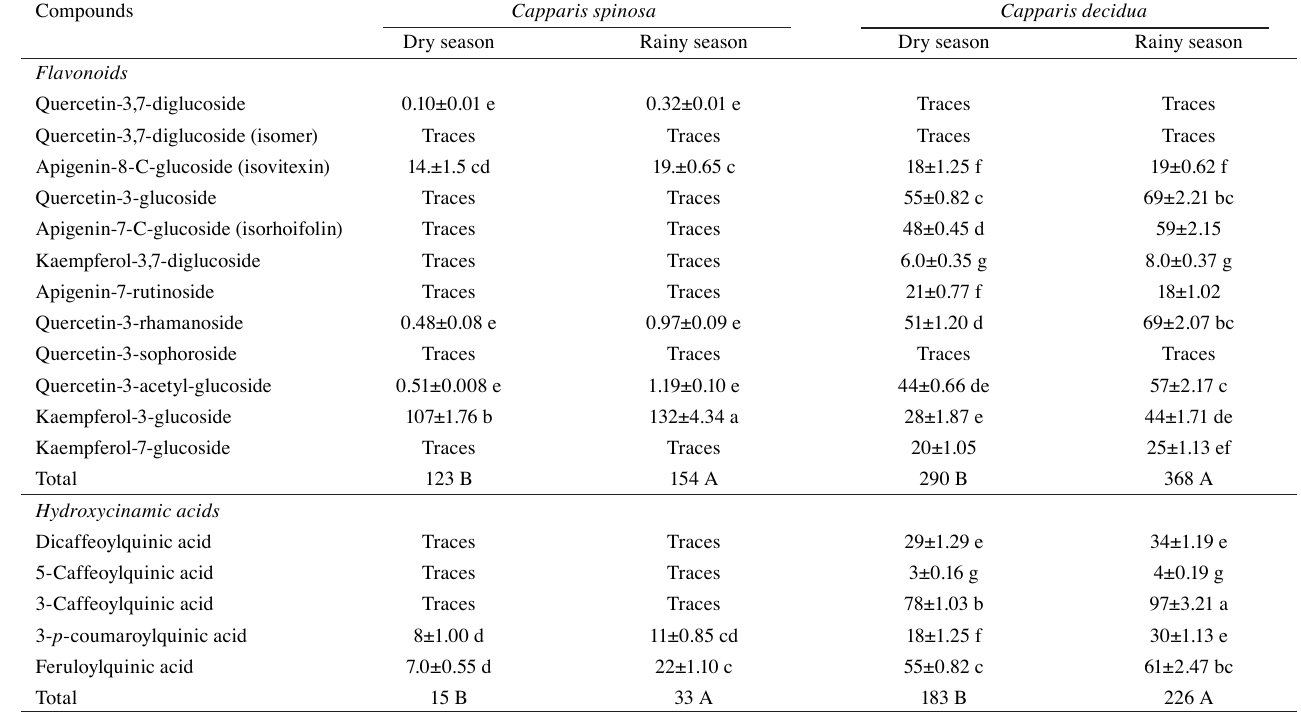
Tab. 5: Identification and quantification of phenolic acids and flavonoids (μg g -1 dw) in root of C. spinosa and Capparis